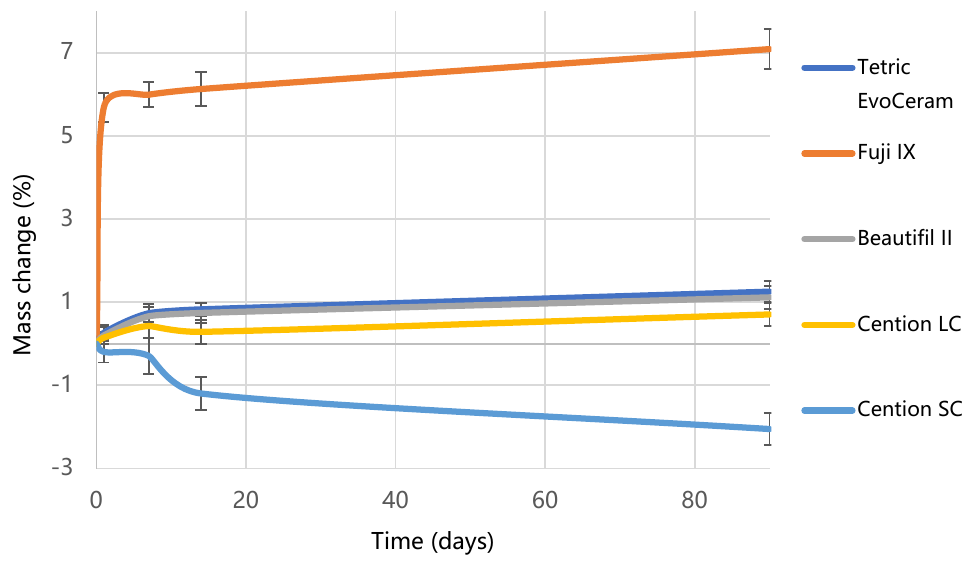
Figure 7. Mass changes over three months of water immersion. Error bars denote standard deviations.